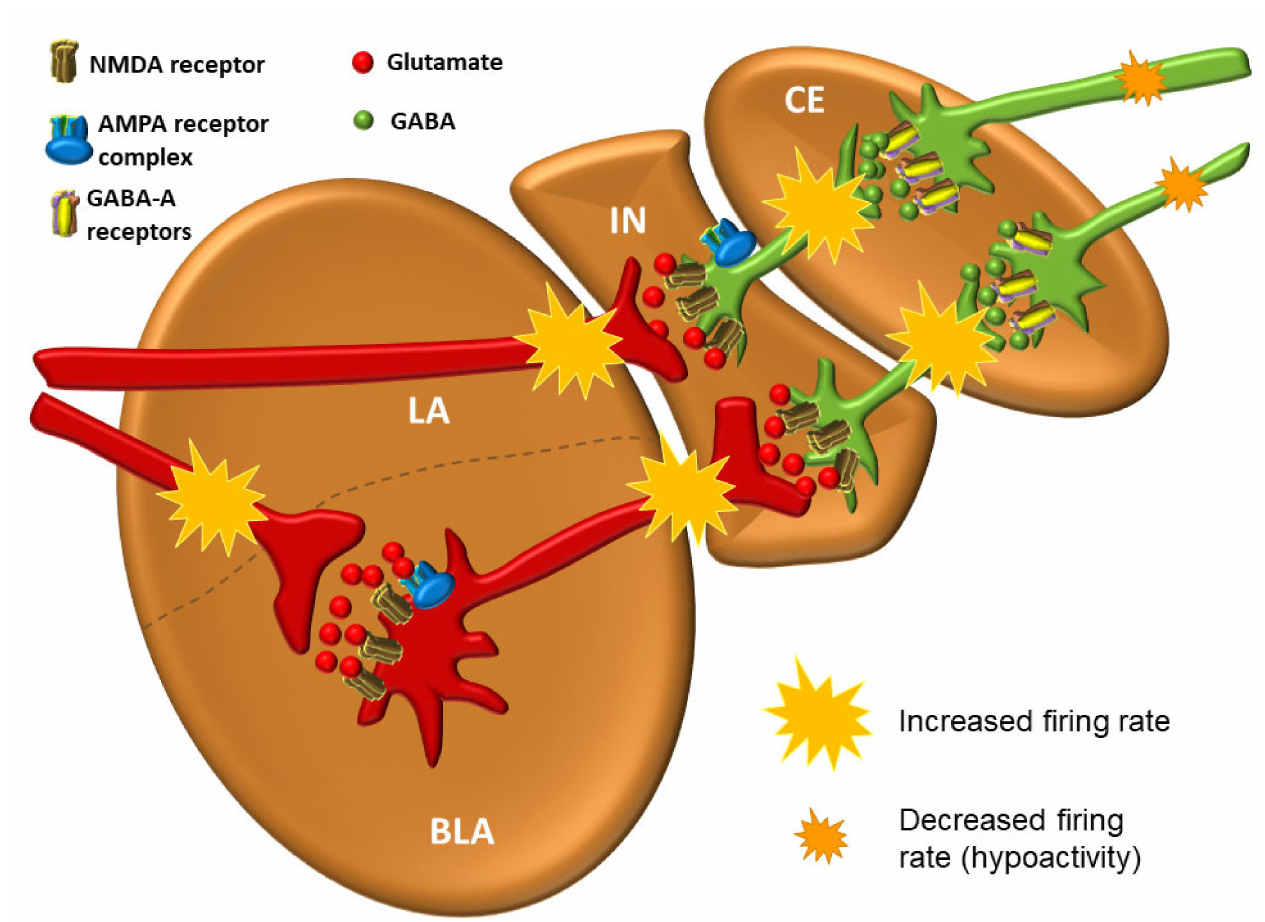
Figure 9. Schematic representation of the predominance of excitation over inhibition in circumstances of imminent danger, but also in anxiety and other functional disorders of the amygdala. The central nucleus of the amygdala contains different populations of GABAergic neurons. This area mediates inhibitory control over the lateral region of the amyg- dala [111]. AMPA— α -amino-3-hydroxy-5-methyl-4-isoxazole propionic acid; BLA—basolateral nucleus of the amygdala; CE—central nucleus of the amygdala; GABA— γ -aminobutyric acid; IN—intercalated neurons; LA—lateral nucleus of amygdala; NMDA— N